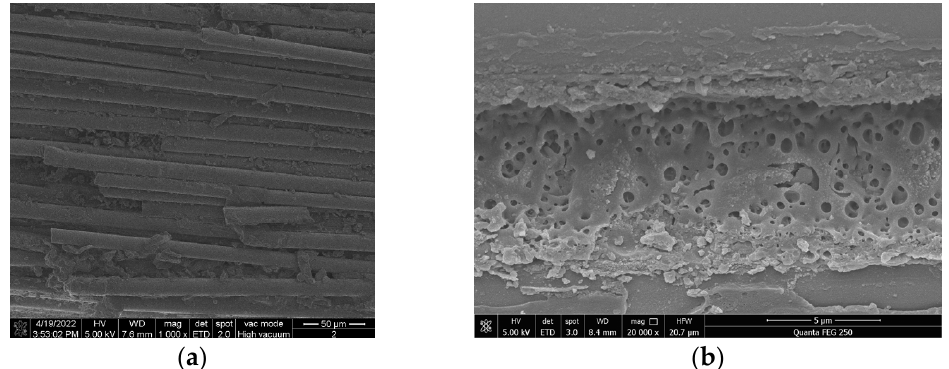
Figure 5. Micromorphology of #1’s mandrel. ( a ) Fiber exposed; ( b ) melting and degradation of epoxy resin.